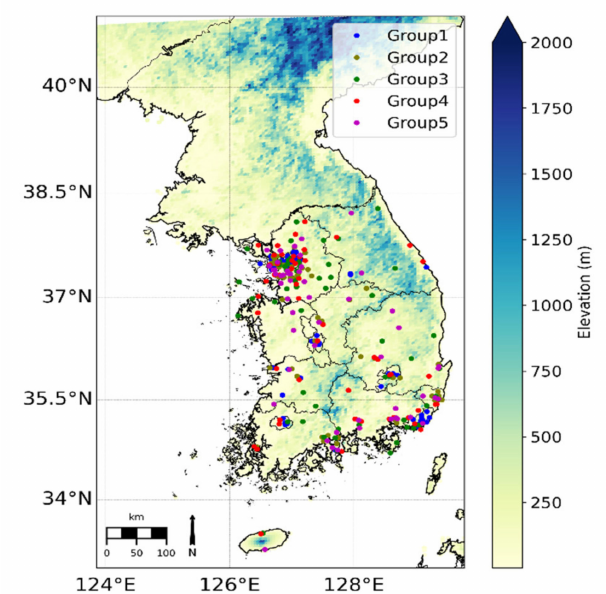
Figure 1. Map of study area denoting elevations and locations of in situ measurements, which were categorized into five groups for